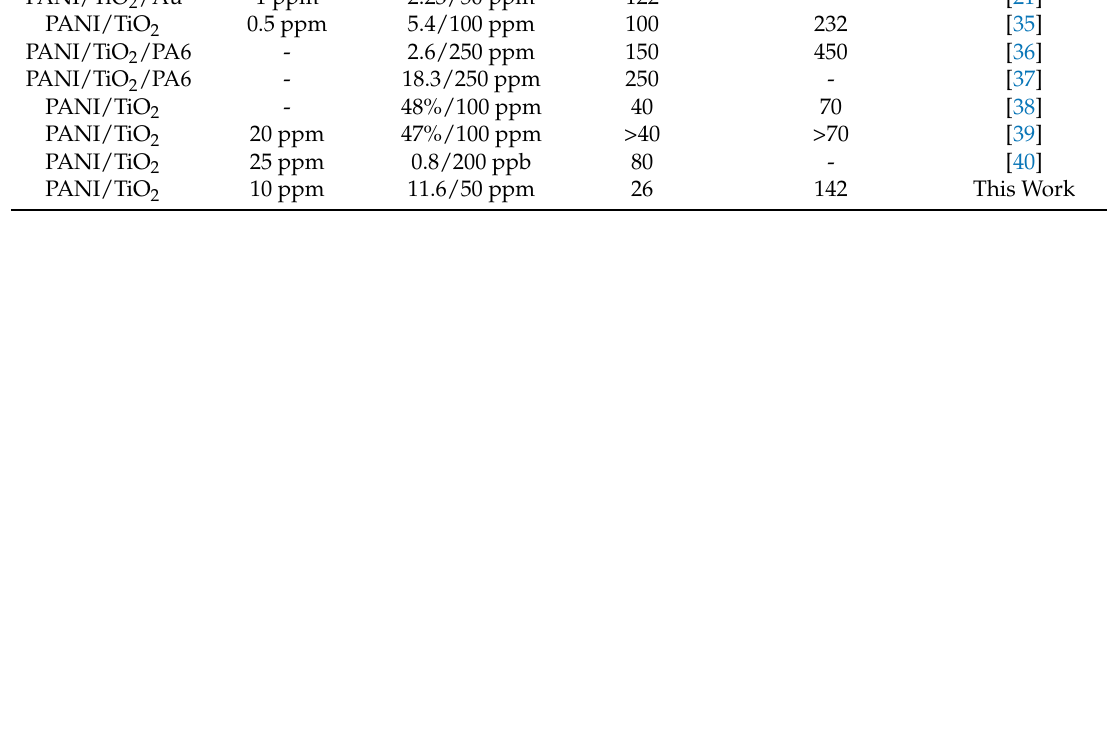
Table 2. Summary of recent publications about the NH 3 detection based the PANI/TiO 2 composites. Materials